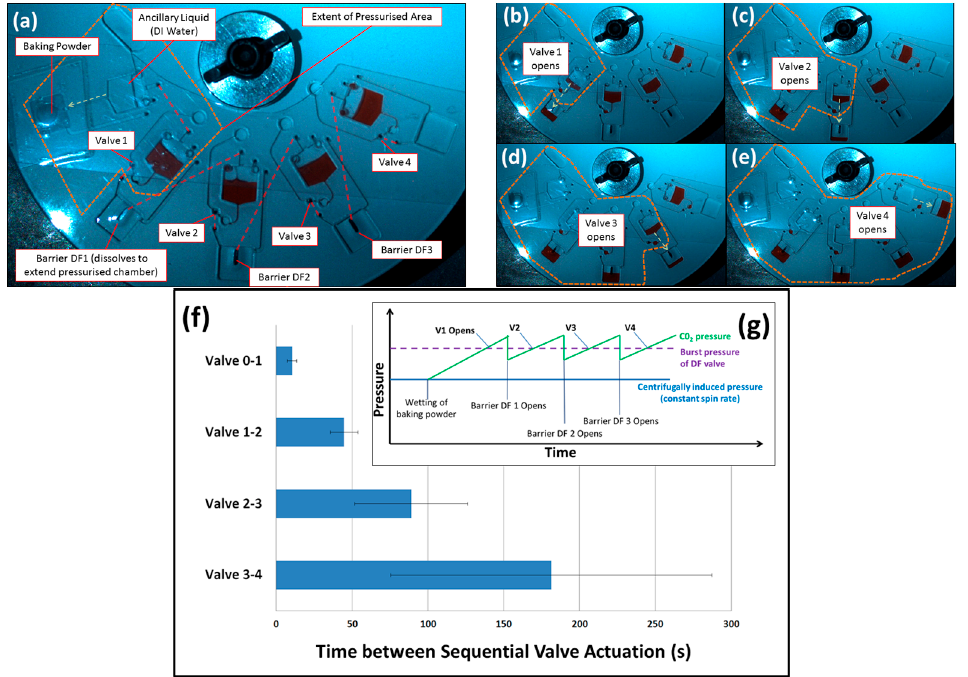
Figure 3. Barrier governed valve actuation. ( a ) Upon contacting the baking powder, the first section of the disc is pressurized to open Valve 1. Red dashed lines show lower-level connecting channels; ( b ) the liquid released from Valve 1 dissolves the DF separating the first chamber from the second; this, in turn, exposes Valve 2 to increased gas pressure; ( c – e ) the subsequent valves open, and the extent of the pneumatic chamber is shown by the dashed line; and ( f ) time between valve actuations ( n = 3). Timing begins when the disc starts to spin. In addition, ( g ) is a qualitative representation of the expected gas pressure changes in the disc; the opening of DF barriers between chambers temporarily reduces the average gas pressure across the chambers. Note that the disc was initially designed so that, in the absence of CO 2 , all of DF burst valves will not trigger at or below 30 Hz spin rate.